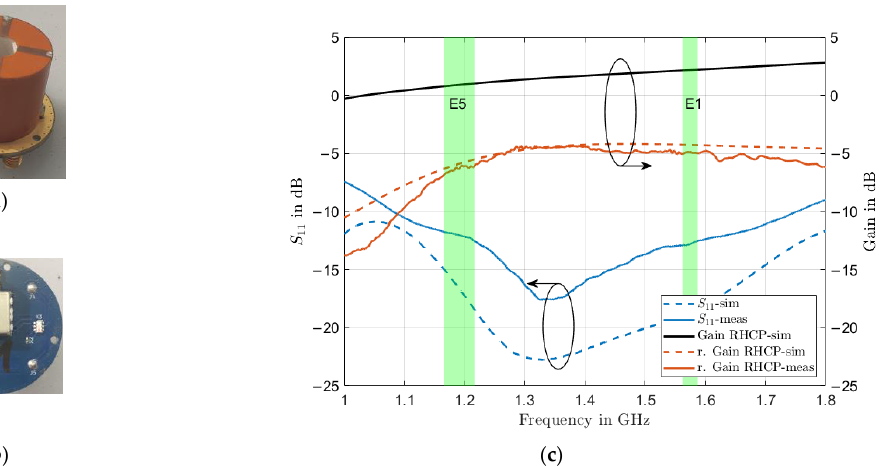
Figure 2. Wideband annular cylindrical dielectric resonator antenna module. ( a ) Resonator body with conductive conformal feed-strips glued on a circular piece of PCB, acting as ground plane; ( b ) Quadrifilar feed-network on the backside of the PCB with SMA connector and soldered pins to con- nect to the feed-strips of the DRA; ( c ) Comparison of simulated and measured S-parameters and realized RHCP gain values at the zenith of the antenna module.